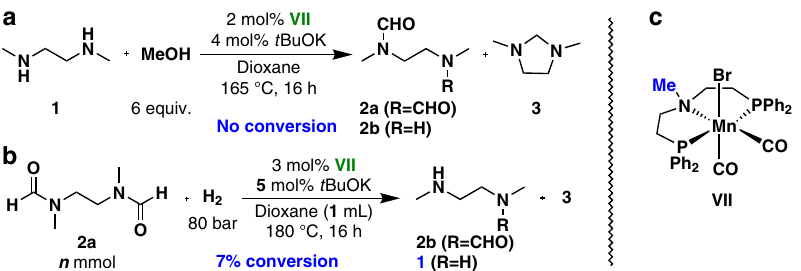
Fig. 3 Mn-catalyzed hydrogenation and dehydrogenation using N-methyl substituted catalyst VII. a VII -catalyzed Dehydrogenation reaction. b VII - catalyzed hydrogenation reaction. c The structure of VII